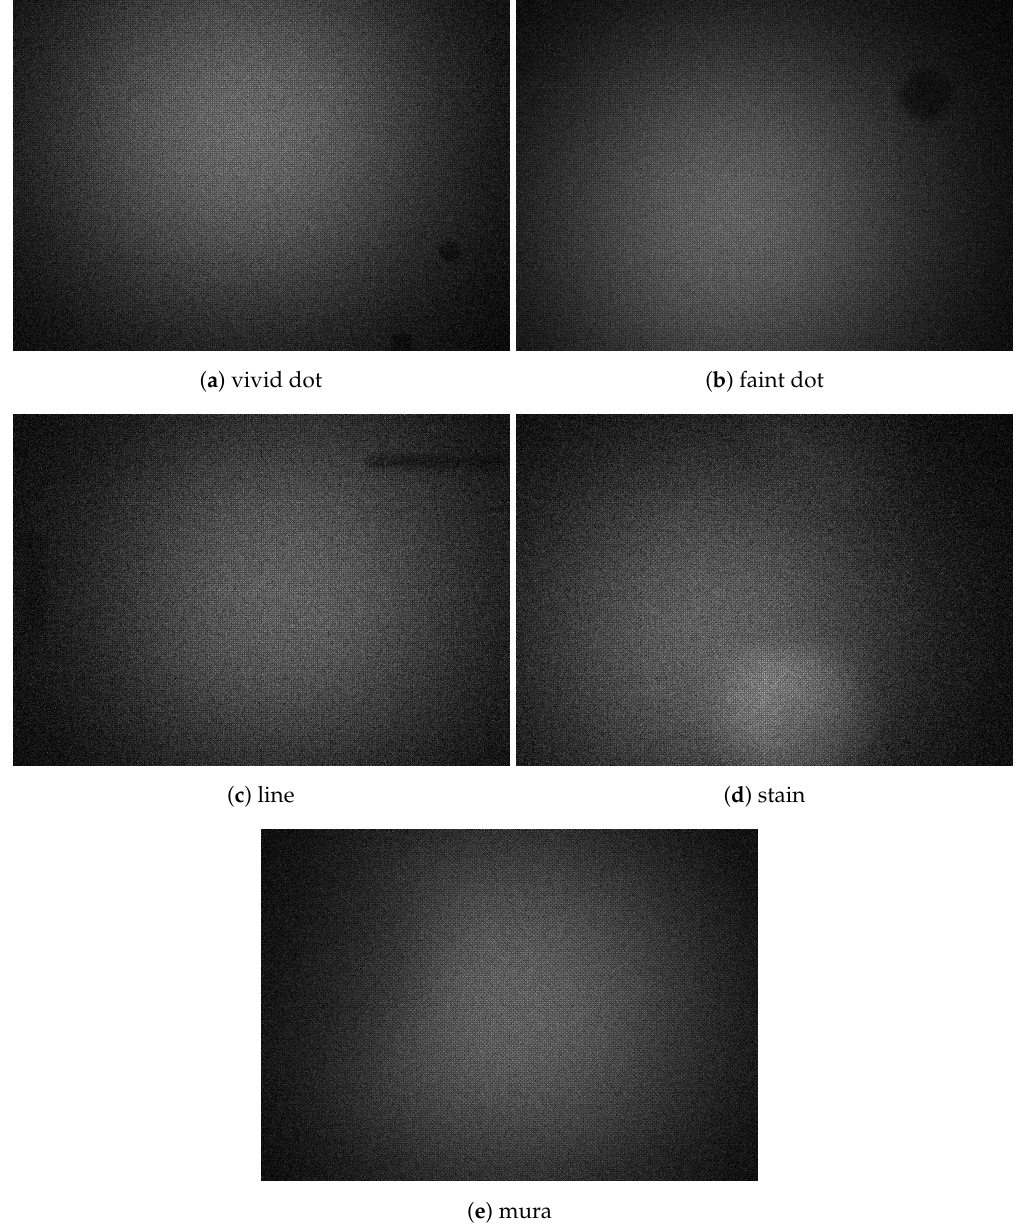
Figure 10. Examples of shaded and noised